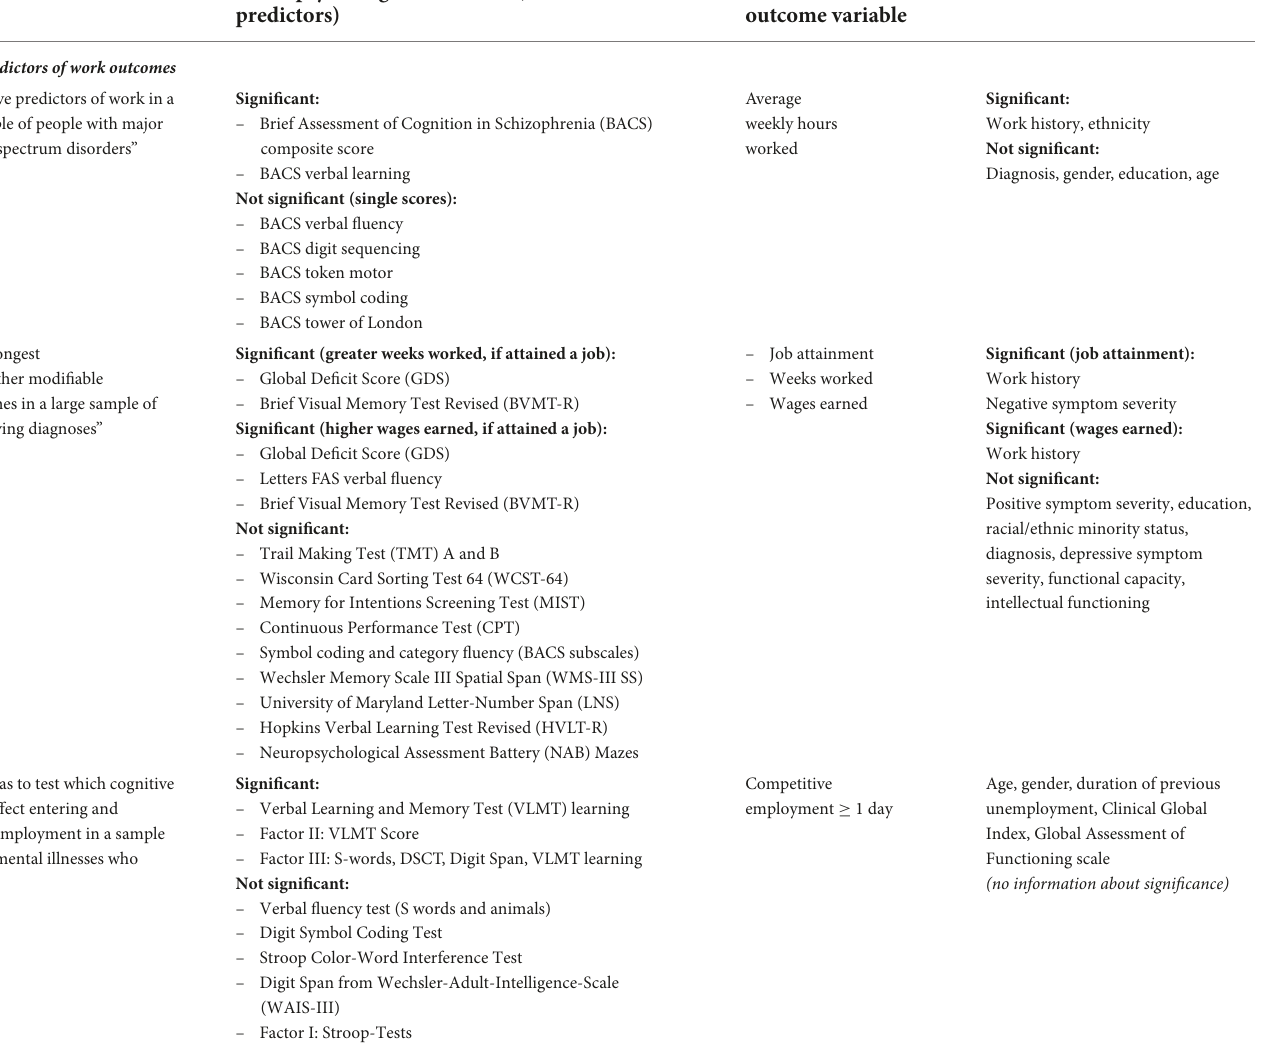
TABLE 2 Information on neuropsychological predictors of work outcomes ( n =